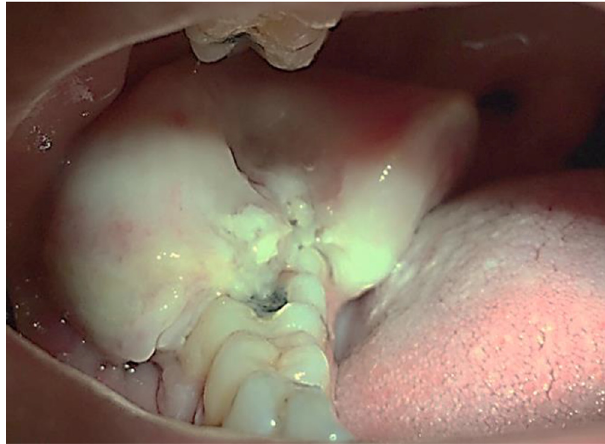
Fig. 1. Gingival large tumour partially covering the mandibular right 2nd molar.